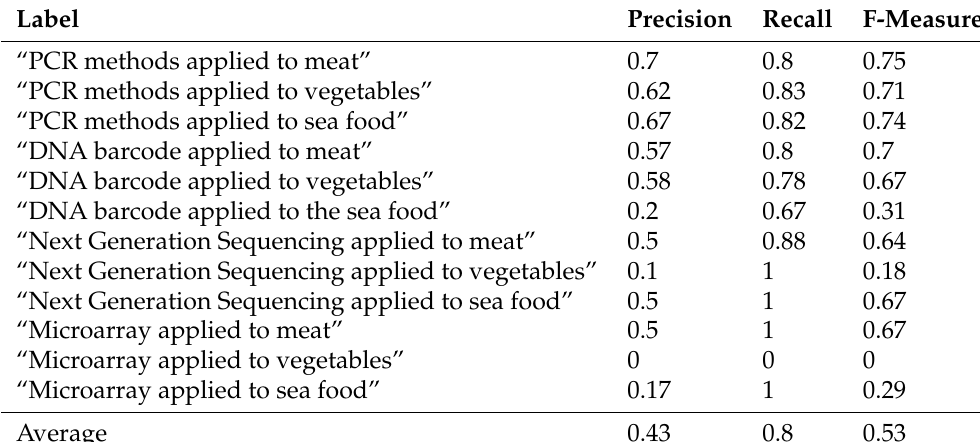
Table 5. Performance of SPUCL.